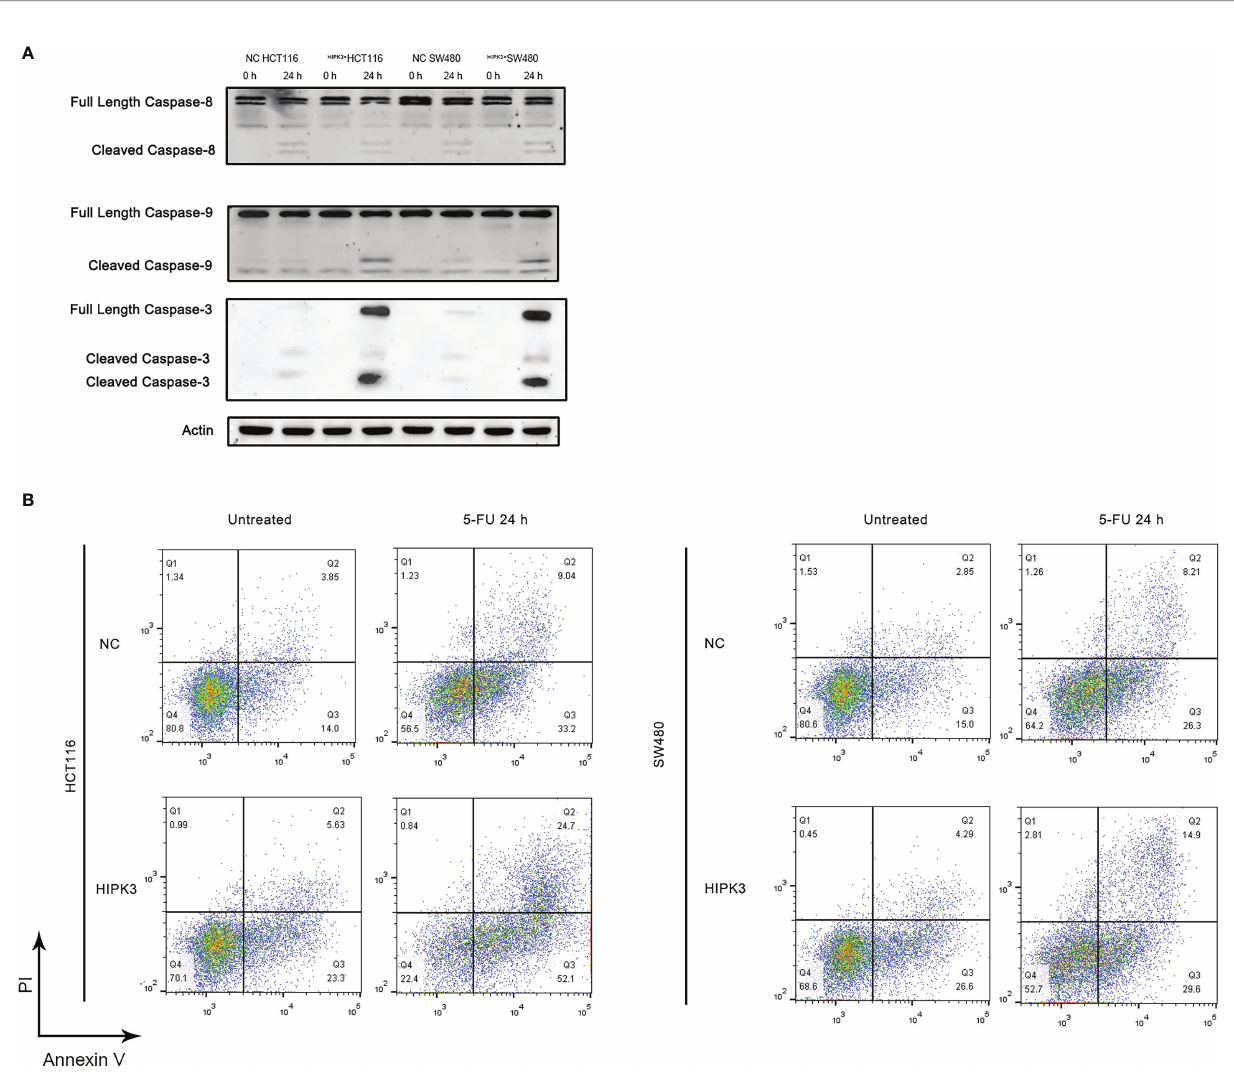
FIGURE 4 | HCT116 and SW480 cells stably over-expressing HIPK3 are more susceptible to 5-FU. (A) Caspase 8, 9, and 3 expression of cells treated by 5-FU. (B) Flow cytometric analysis of apoptosis using PI/Annexin V dual